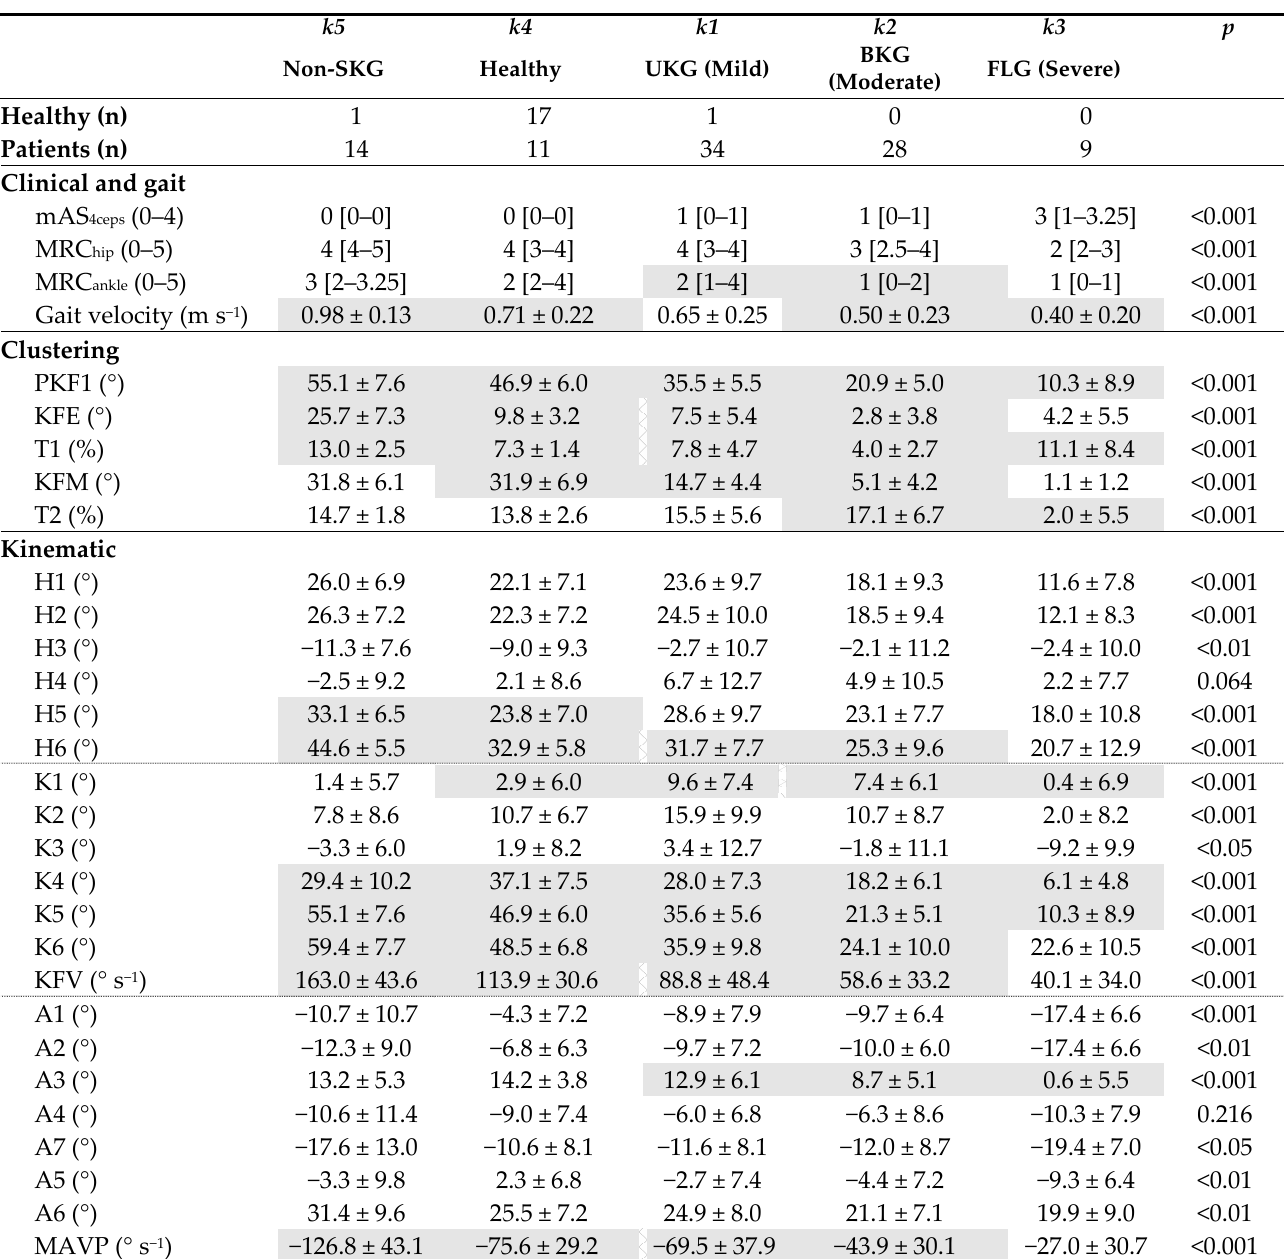
Table 4. Clustering results, clinical and gait characteristics (median and [1st–3rd quartiles]), and sagittal kinematic parameters (mean ± SD) for the different clusters ( k1 to k5 ) and results of the one-way ANOVA or Kruskal–Wallis tests.